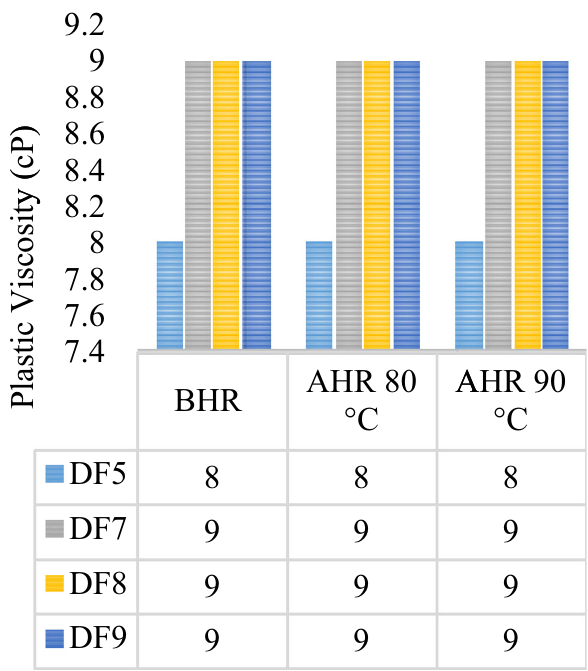
Fig. 10 Variation of PV after hot rolling